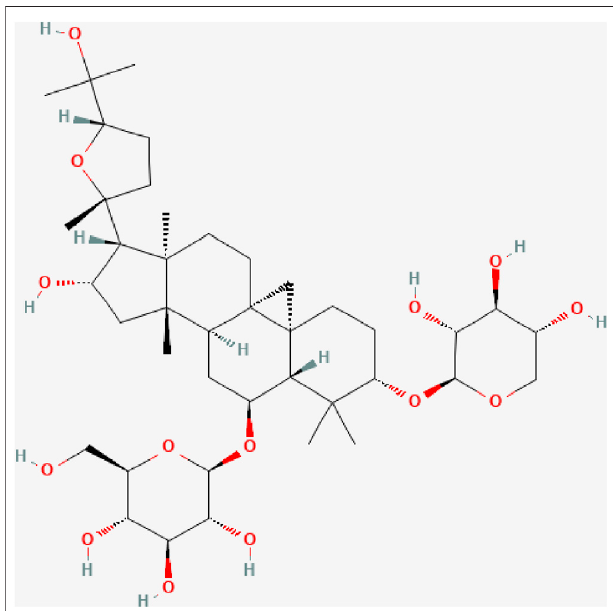
FIGURE 1 | The chemical structure of Astragaloside